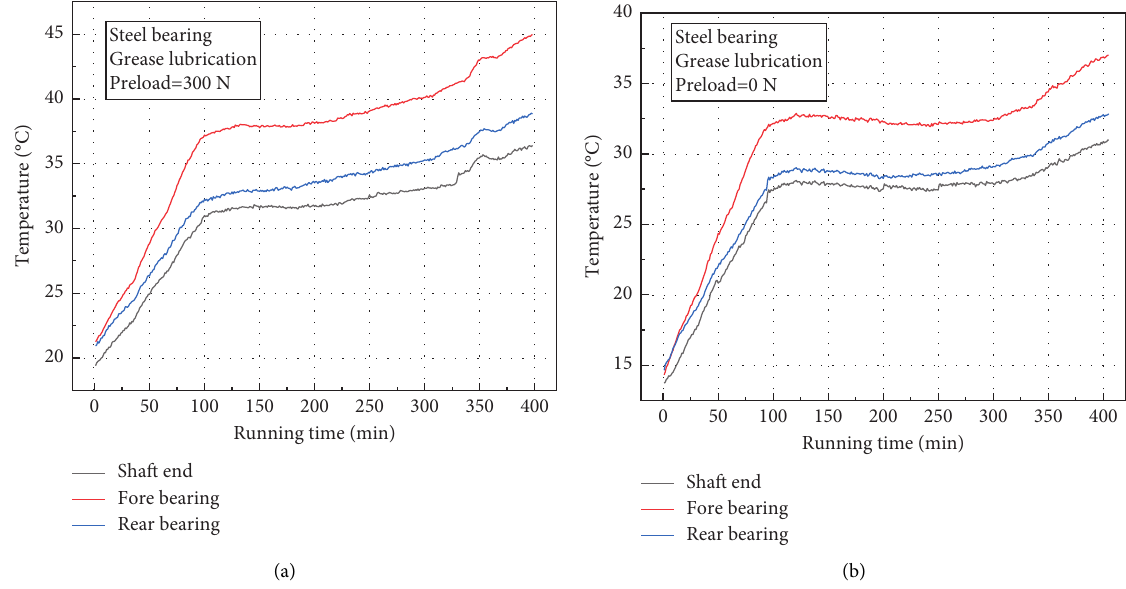
Figure 14: Temperature rise of steel bearings under grease lubrication condition. (a) Condition of applying preload. (b) Condition of no preload.